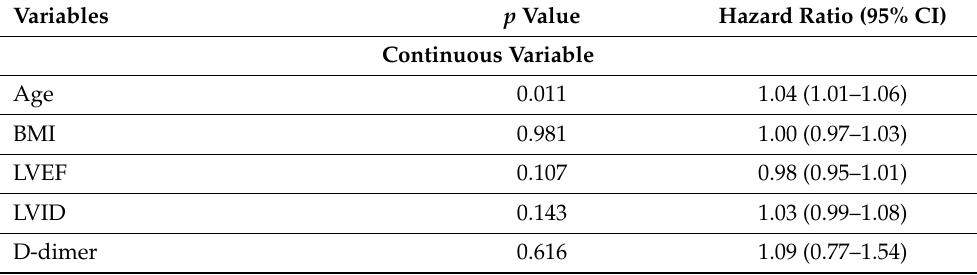
Table A1. Univariable Cox regression in derivation